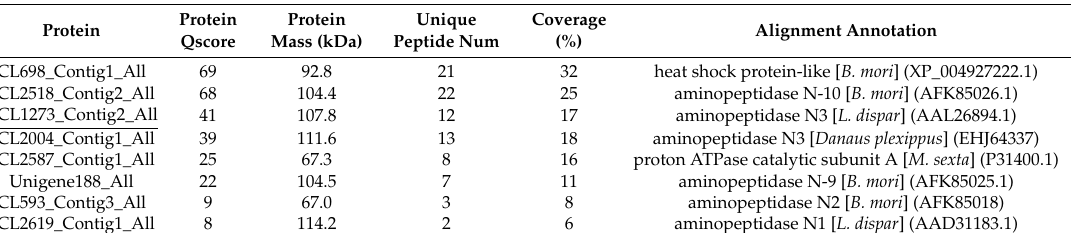
Table 1. Candidate Cry1Ab35 binding proteins identified from the 115 kDa band from H. cunea BBMV by LC-MS/MS.